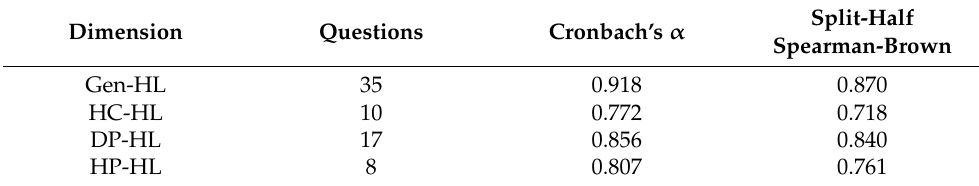
Table 3. Reliability of CPHLQ-Psychological Part. Dimension Questions